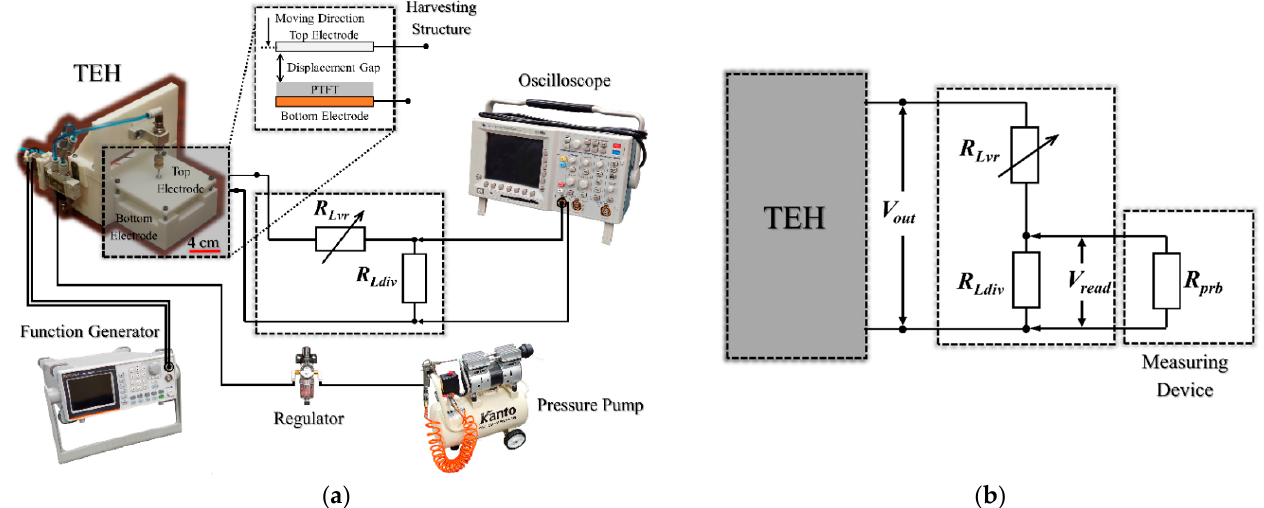
Figure 3. Schematic diagram of ( a ) experimental set-up and ( b ) circuit schematic of measurement technique.